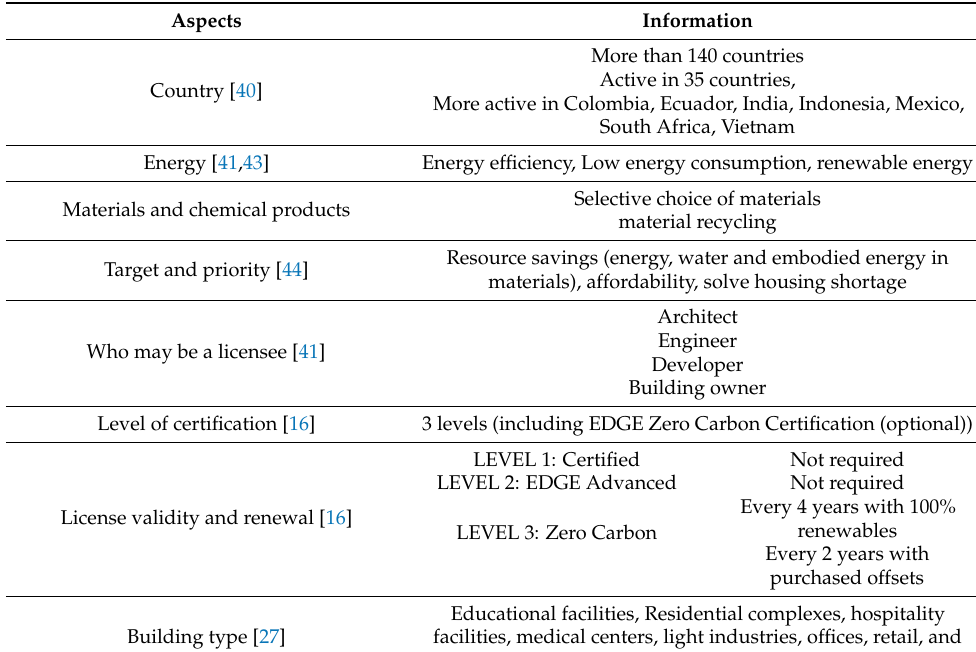
Table 3. Summarized characteristics of EDGE certification